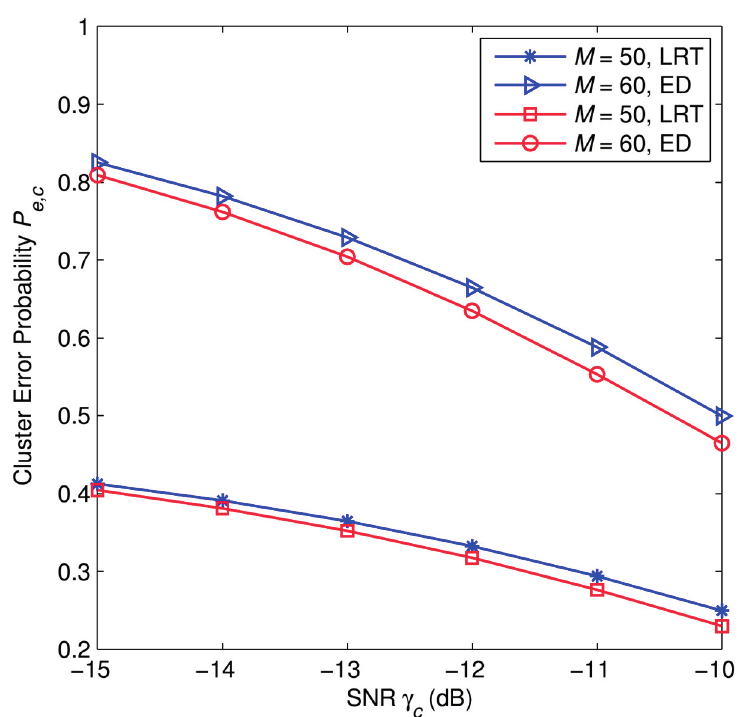
Figure 6. The comparison of sensing performances between soft combination scheme (at a cluster head) using the Likelihood Radio Test (LRT) and the one using the Energy Detector (ED) under different SNRs with N = 4